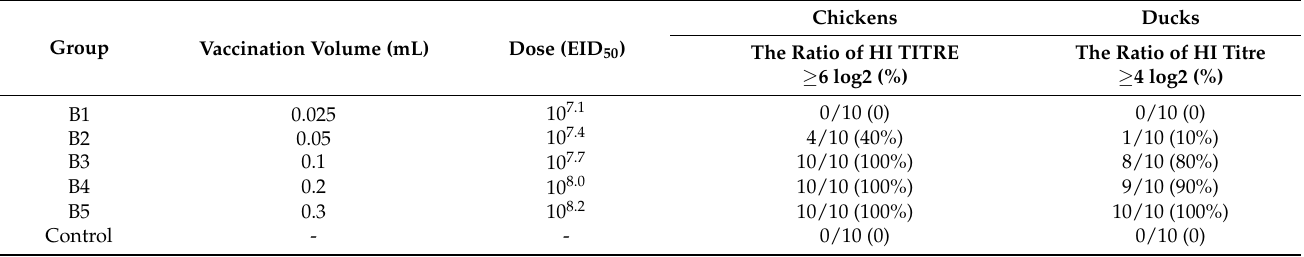
Table 3. The HI antibody titres of chickens and ducks immunized with various doses of inactivated vaccine.